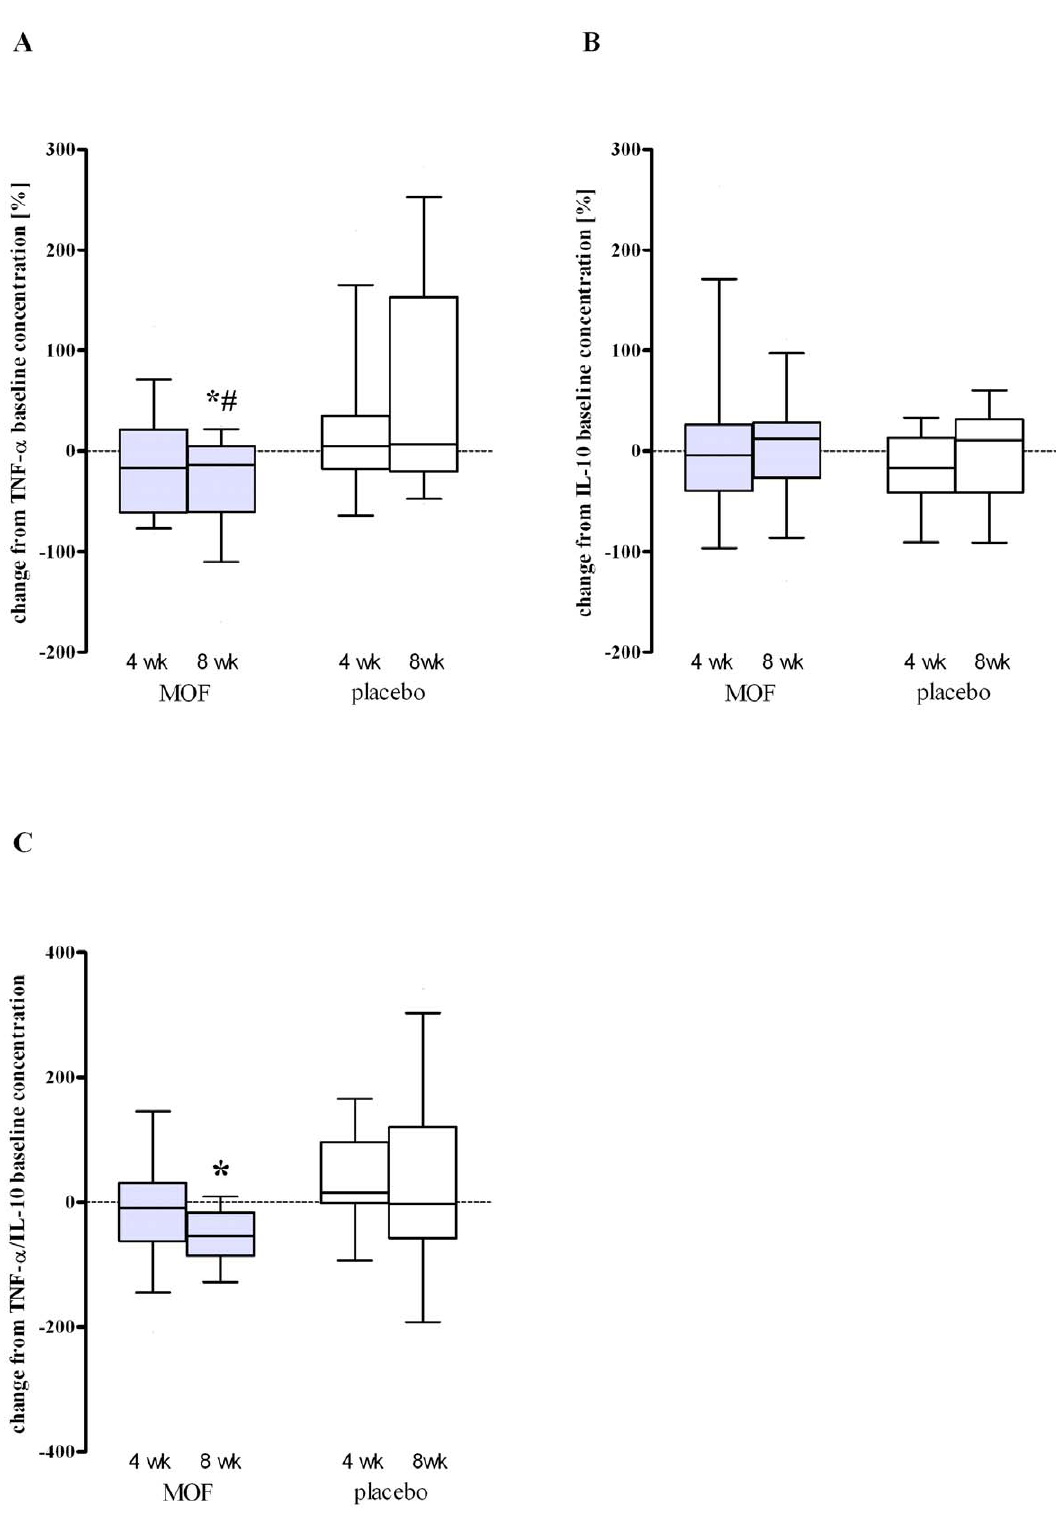
Figure 2. Changes from baseline in median (10 th to 90 th percentile) cytokine concentrations released upon LPS-addition (100 ng/ mL) to subjects’ blood exvivo after 4 and 8 wk supplementation with either 200 mg/d monomeric and oligomeric flavanols (MOF, n=15) or placebo (n=13): (A) TNF- a , percentage change; (B) IL-10, percentage change; (C) ratio of TNF- a to IL-10, absolute change. Within-group changes were appraised by Wilcoxon Signed Ranks test, between-group changes by Mann-Whitney U test; * Significantly different from baseline in the same group, P , 0.05. # Significant difference between groups at the same time, P , 0.05.